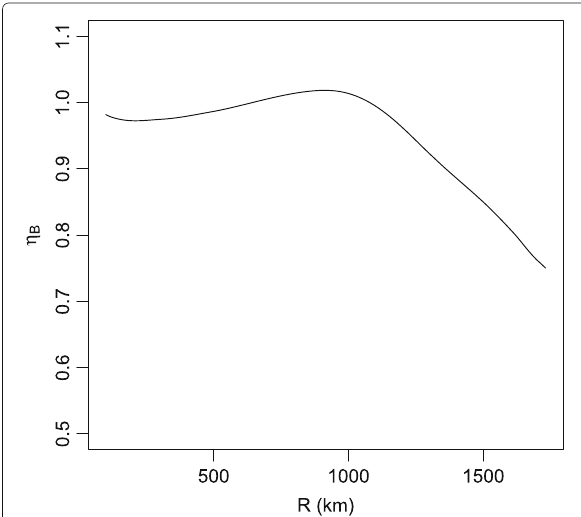
Fig. 11 Plot of homogeneity index for stratified core based on Rivoldini et al. (2011) model. The index η B is 1 for self-compression of a homogeneous substance. The bulk sulfur content is 11 wt%, and T CMB = 1700 K. This causes the topmost ∼ 500 km of the core to be enriched in sulfur compared to the bulk. The index is approximately 1 in the innermost part of the outer core, but uniformly decreases in the topmost 500 km of the outer core where the sulfur concentration increase changes the wavespeed more strongly than the increase in pressure in a homogeneous material